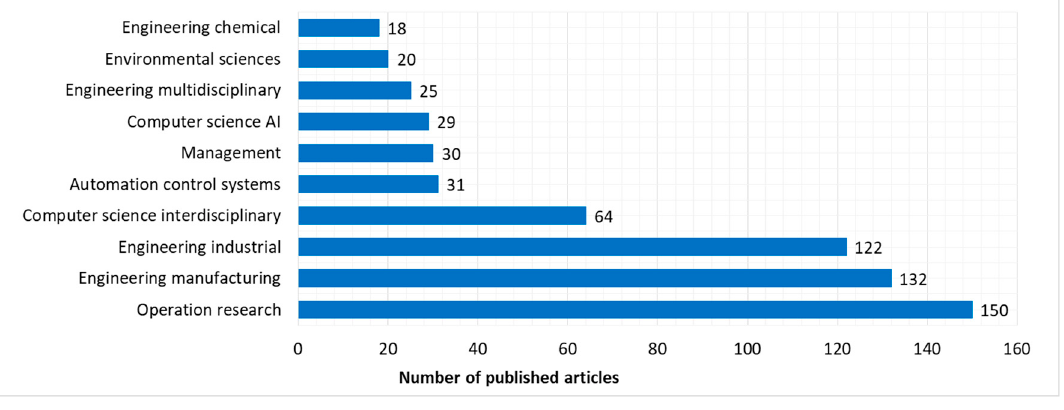
Figure 1. Classification of articles considering subject areas based on a search in Web of Science database using TOPIC: “manufacturing” AND “logistics” AND “optimization”.